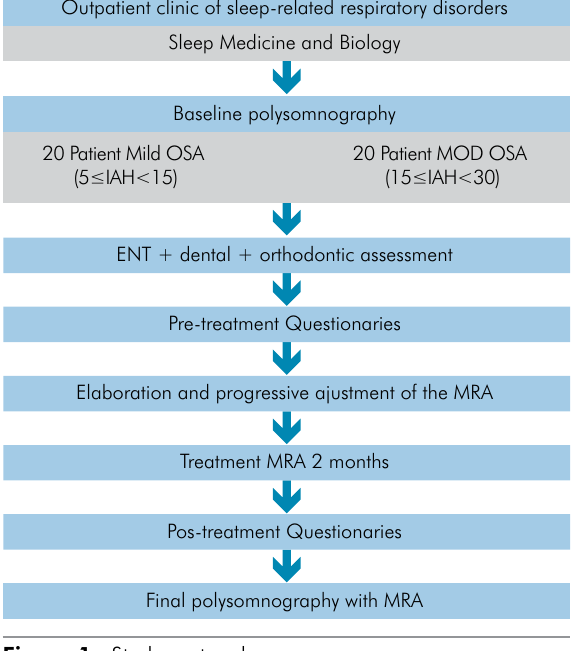
Figure 1. Study protocol.